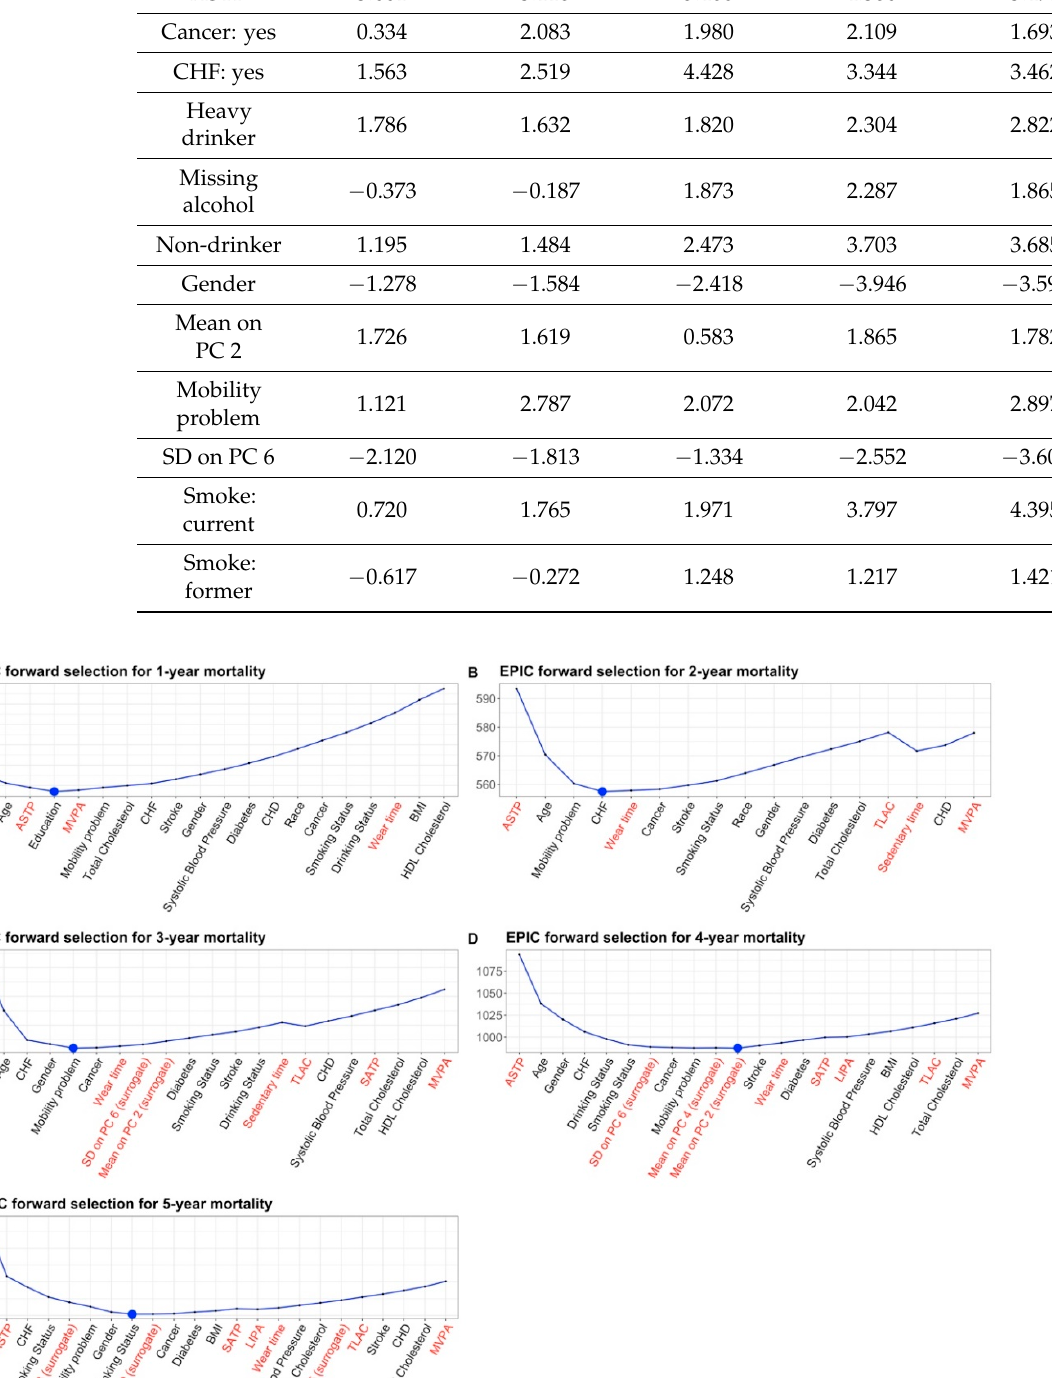
Table A3. t-statistic values of the variables selected in the combined model across years .